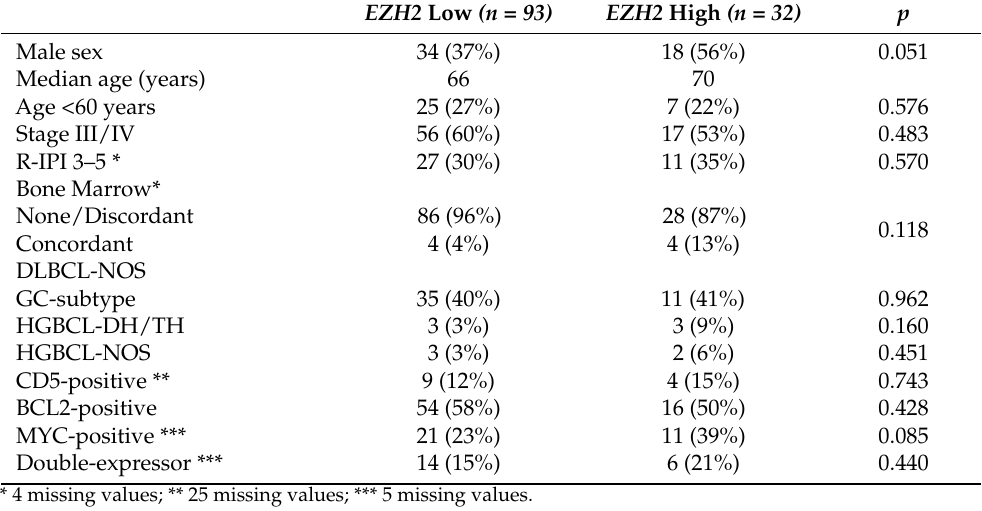
Table 2. Baseline characteristics of the study cohort according to EZH2 expression.